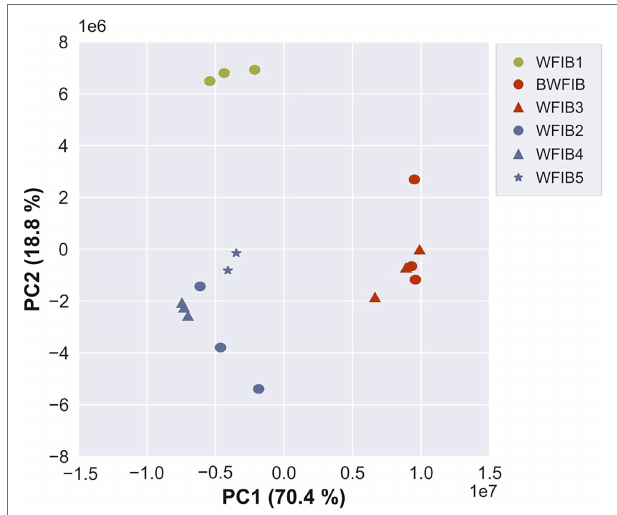
FIGURE 6 | PCA of the FTIR spectra (3,500–500 cm − 1 region) of 6 wood fibre insulation boards: score plot of PC1 (70.4%) vs. PC2 (18.8%).